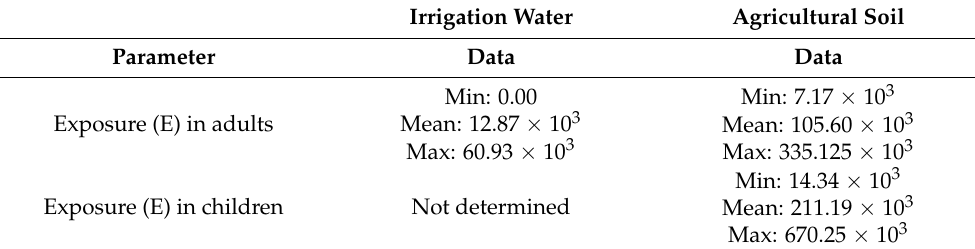
Table 4. The exposure parameters in adults and children.